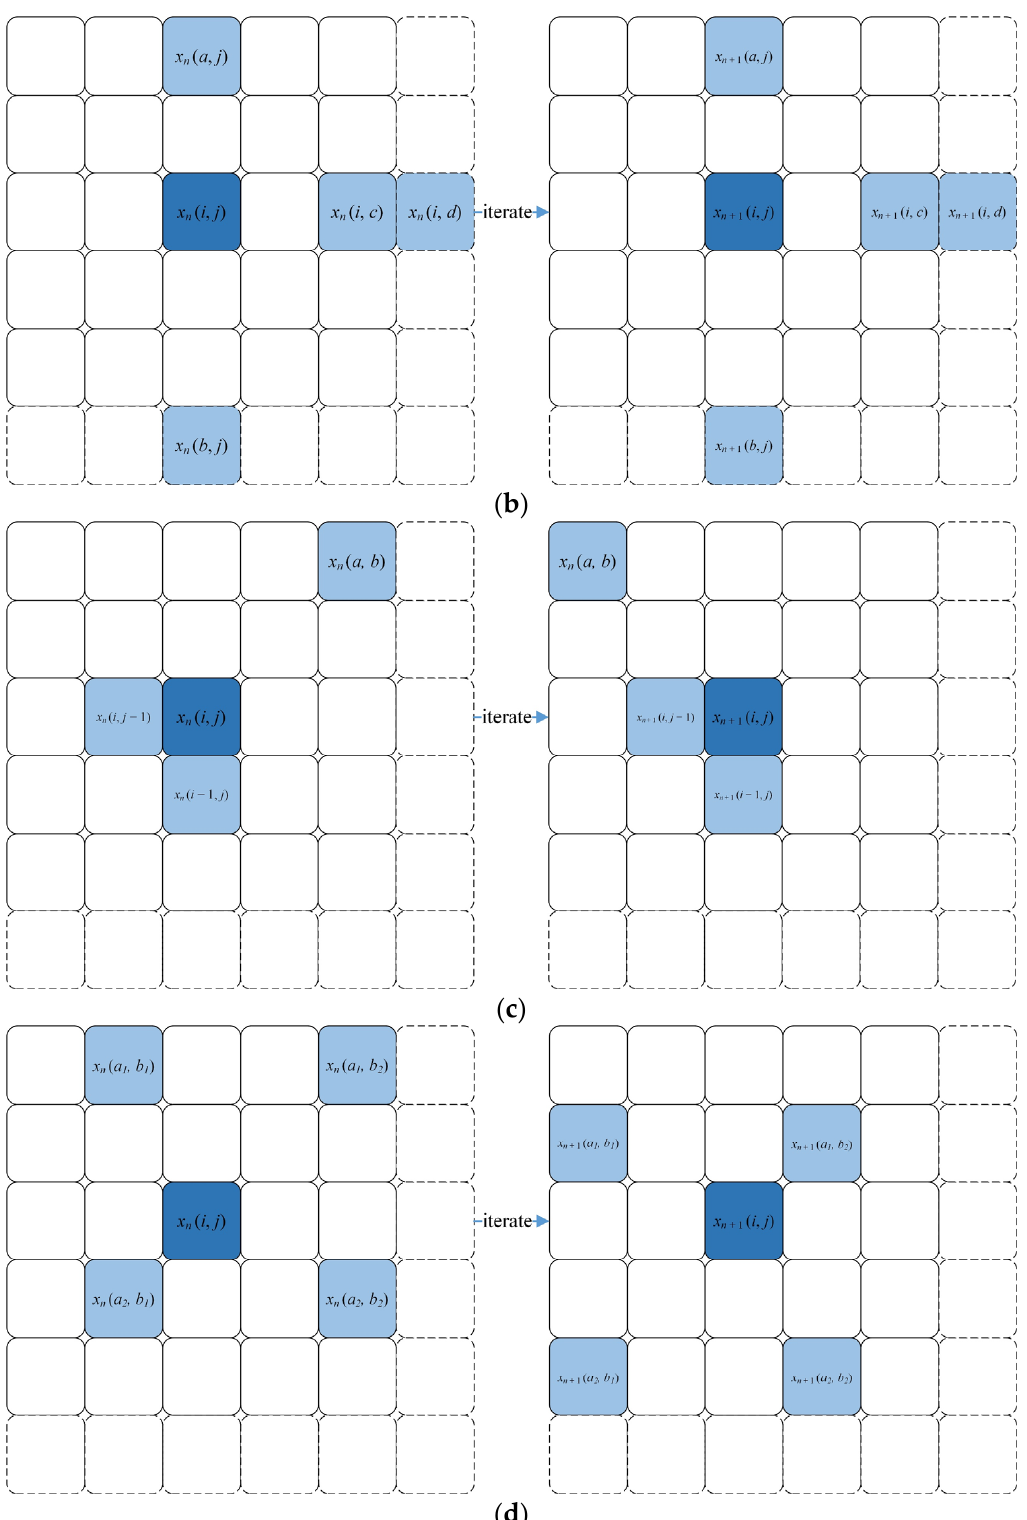
Figure 3. The coupling schemes of ( a ) 2D-CML, ( b ) 2D-NLCML, ( c ) 2D-MCPML and ( d ) 2D-DPRCML. The dark blue lattice denotes the current lattice for calculation, and the light blue lattices represent the lattices for coupling.